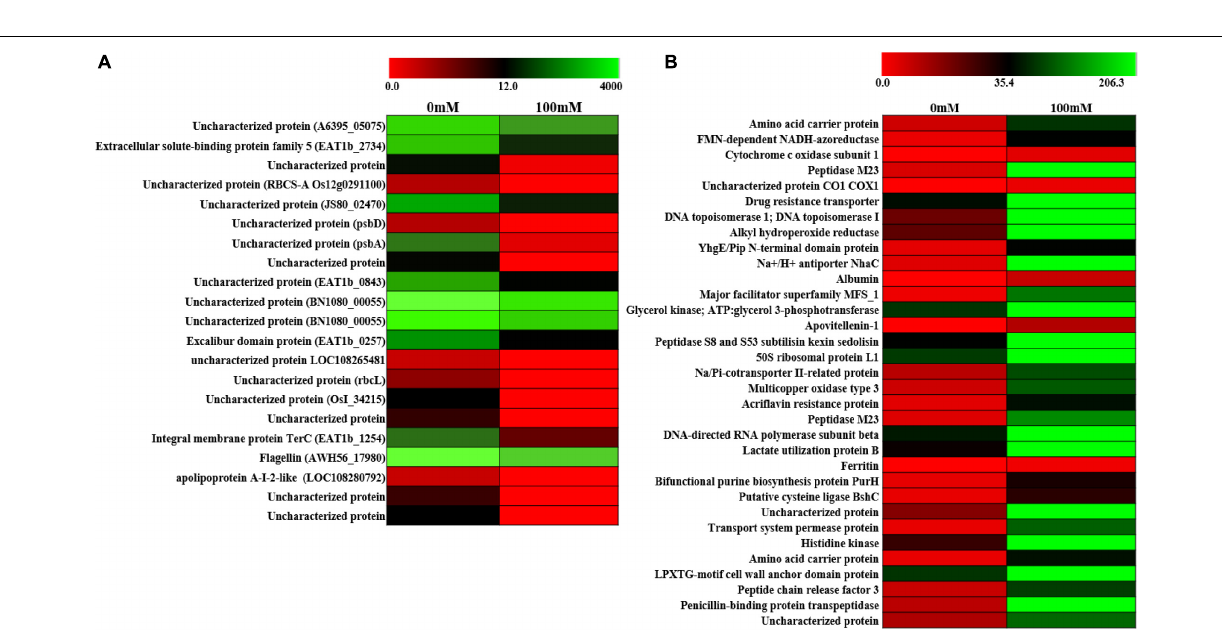
Frontiers in Microbiology |